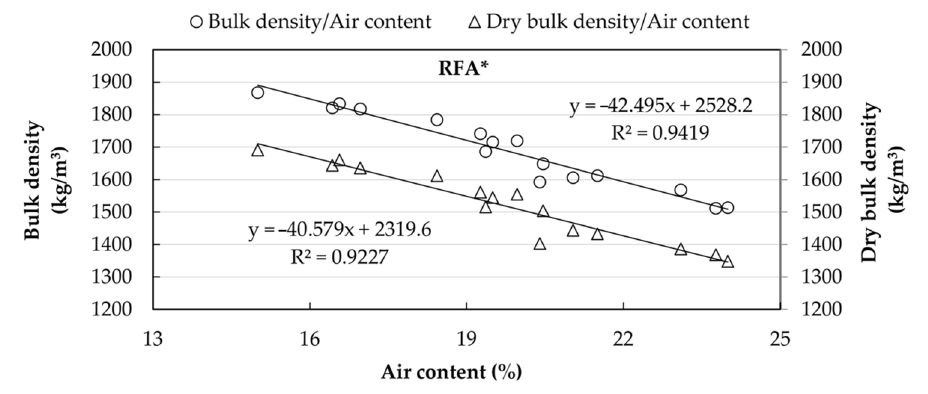
Figure 11. Correlation between densities (fresh and dry state) and the air content for in mortar made with RFA*.